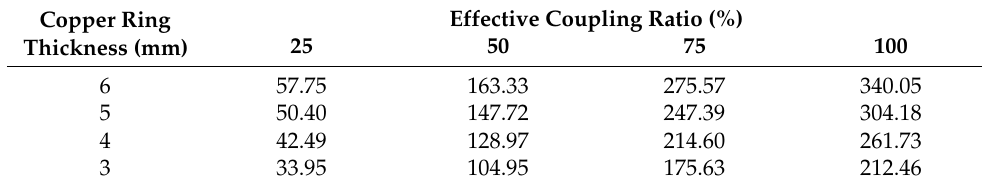
Table 3. Output torque at different copper ring